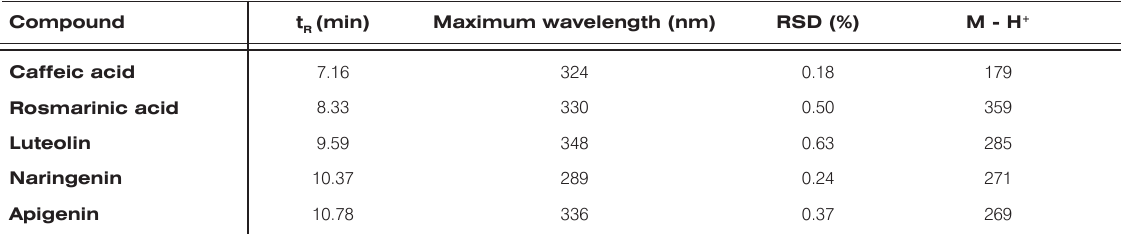
Table 1. Polyphenolic compounds identified in Satureja hortensis L. extracts.